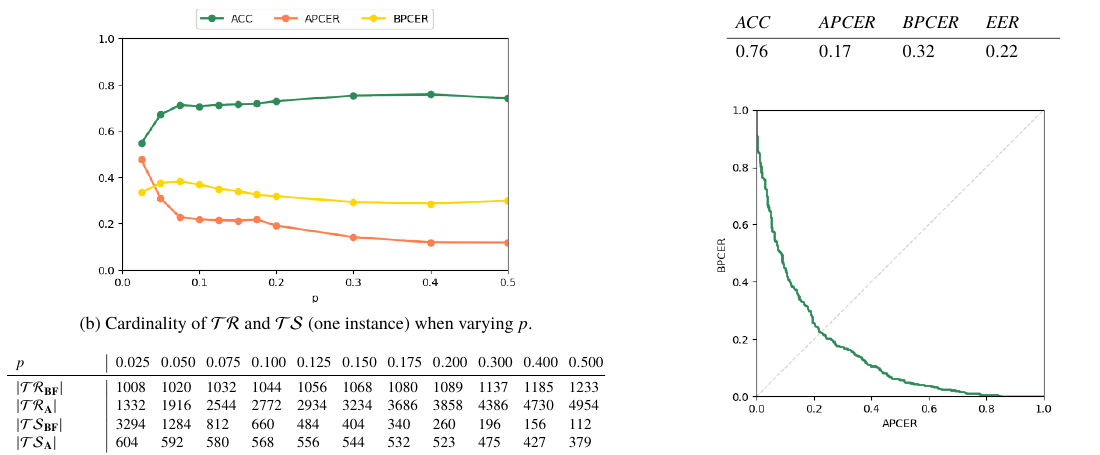
Figure 8. Results for the Mixed scenario.